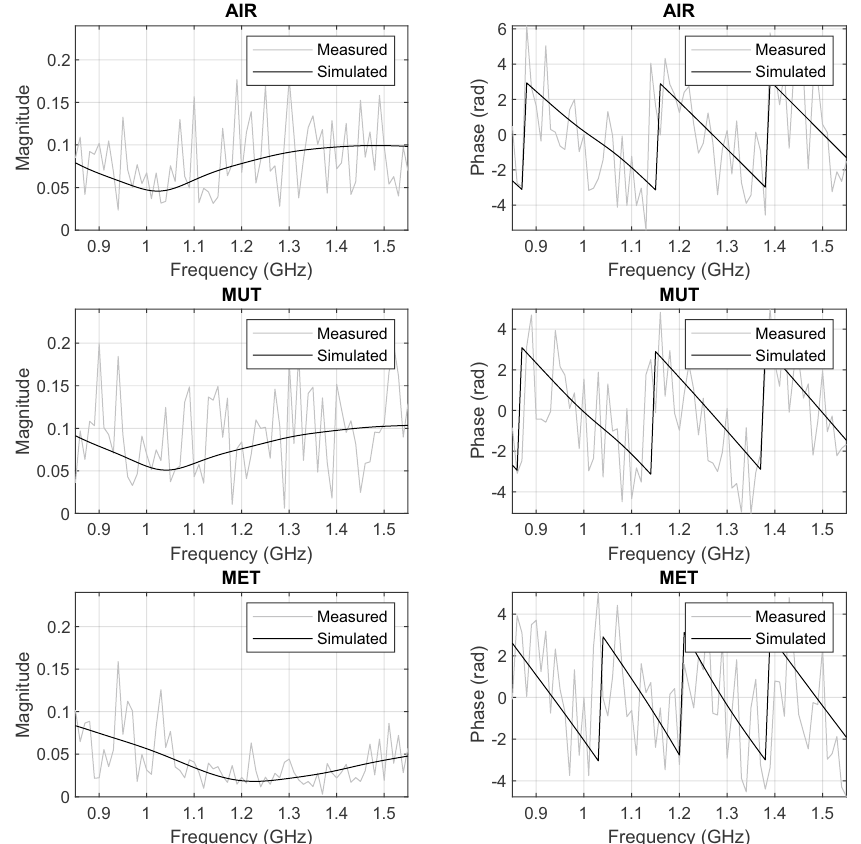
Figure 12. Measured and simulated complex signals for the three configurations, using the optimized values of Table 1. Magnitudes are on the left and phases are on the right. The configurations from top to bottom are AIR, MUT and